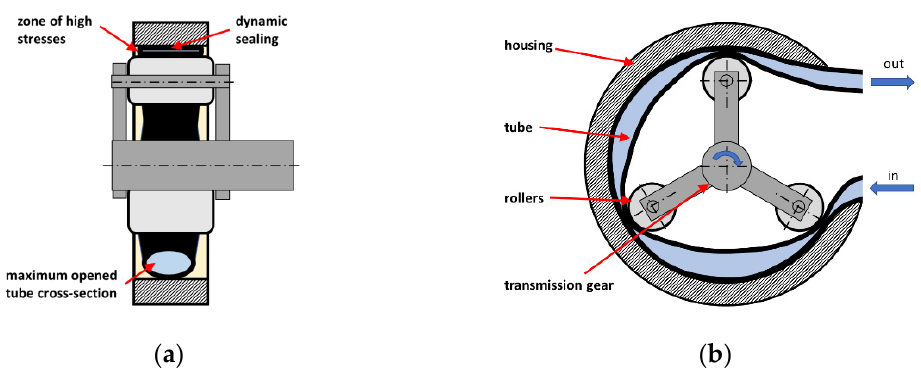
Figure 1. Flexible tube based peristaltic pump principle with 3 rollers; ( a ) cross-section of the pump in frontal-view; ( b ) cross-section of the pump in side-view.